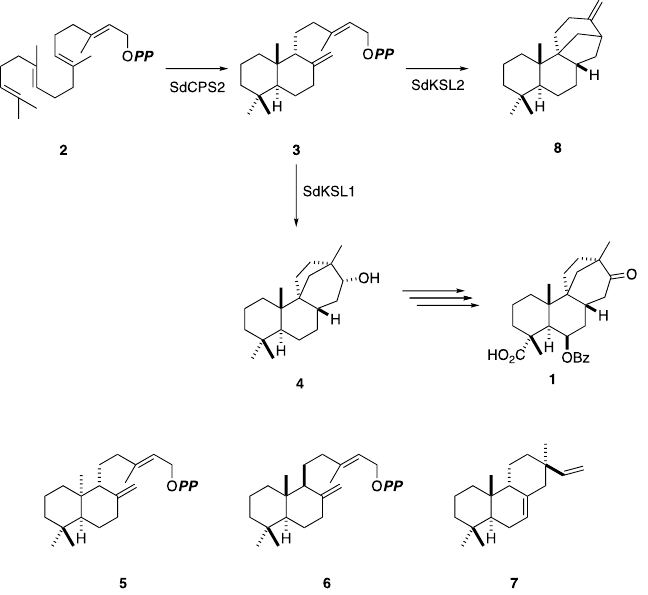
Scheme 1. Proposed biosynthetic pathway of diterpenes in S. dulcis and chemical structures of